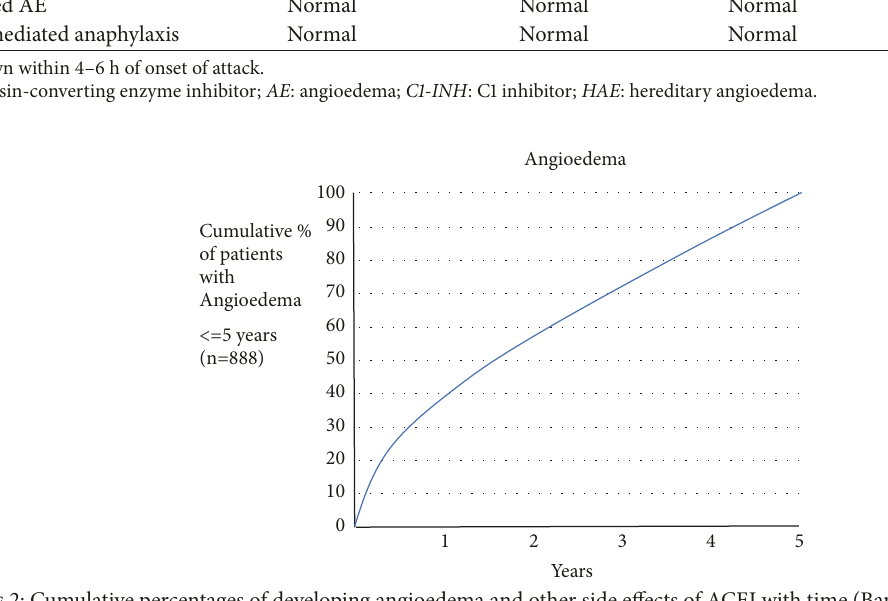
Figure 2: Cumulative percentages of developing angioedema and other side effects of ACEI with time (Banerji et al., 2017) [6].